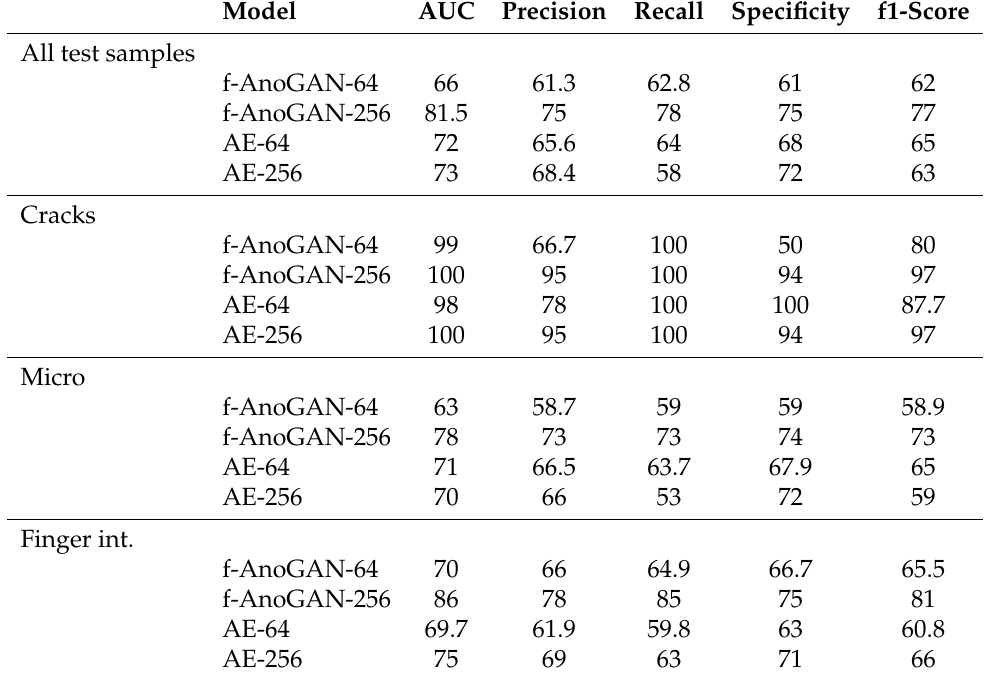
Table 3. The results of anomaly detection at the image-level. Precision tells how accurate the classifier is when classifying a sample as defective. Recall tells how many samples have been correctly classified as defective from all defective samples. Specificity describes how many defect-free samples have been correctly classified as defect-free samples. The F1-score is the harmonic mean of the Precision and Recall. In all metrics, the higher the value, the better the classifier is.